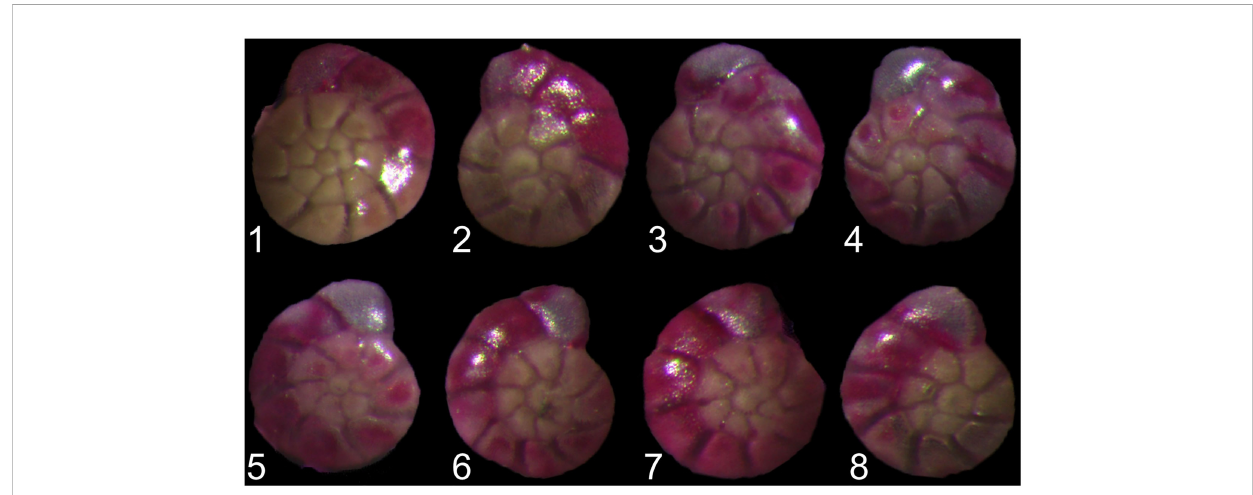
FIGURE 1 Ammonia aomoriensis (Asano, 1951) speciemens with sinistral (1 – 4) and dextral (5 – 8) coiling